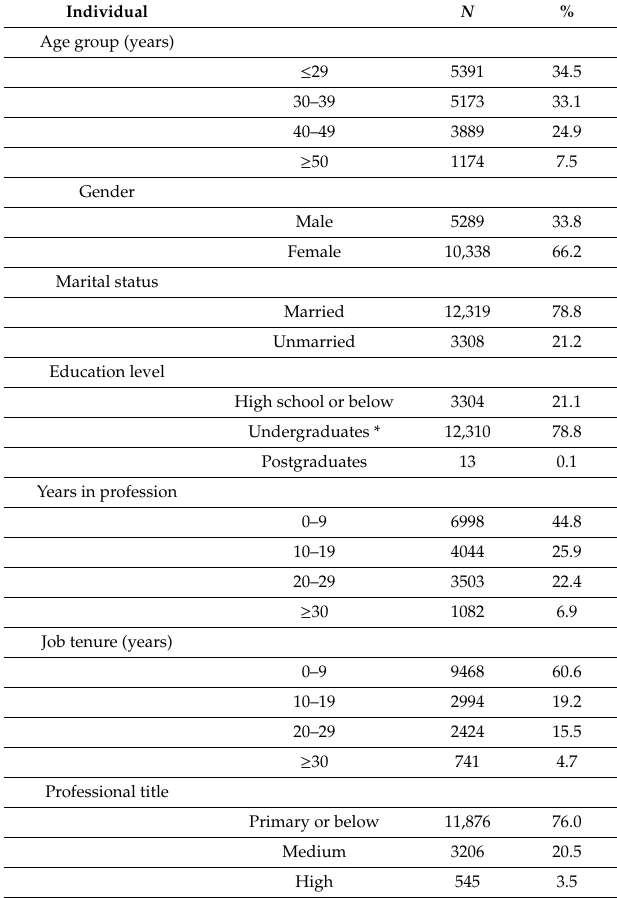
Table 1. General characteristics of the sampled participants ( n = 15,627) and institutions ( n = 459). Individual